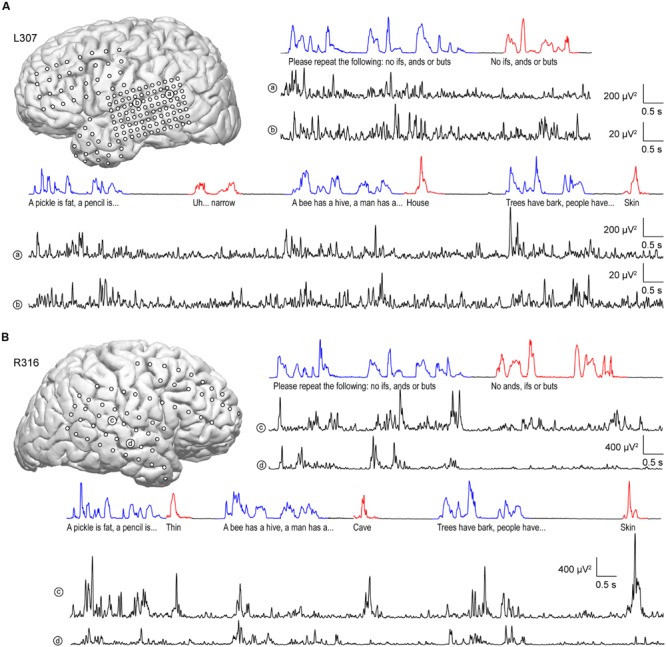
Activity in STG during performance of the expanded MMSE. (A) Data from left (language-dominant) STG (subject L307). Inset: MRI view of left hemisphere showing the locations of chronically implanted subdural electrodes. Speech envelopes of two excerpts of the conversation (interviewer’s and subject’s utterances highlighted in blue and red, respectively) are shown along with simultaneously recorded high gamma power from two representative sites in posterior and middle STG (a and b, respectively) underneath. (B) Data from right (language non-dominant) STG (subject R316). Panels are arranged in the same way as in (A).